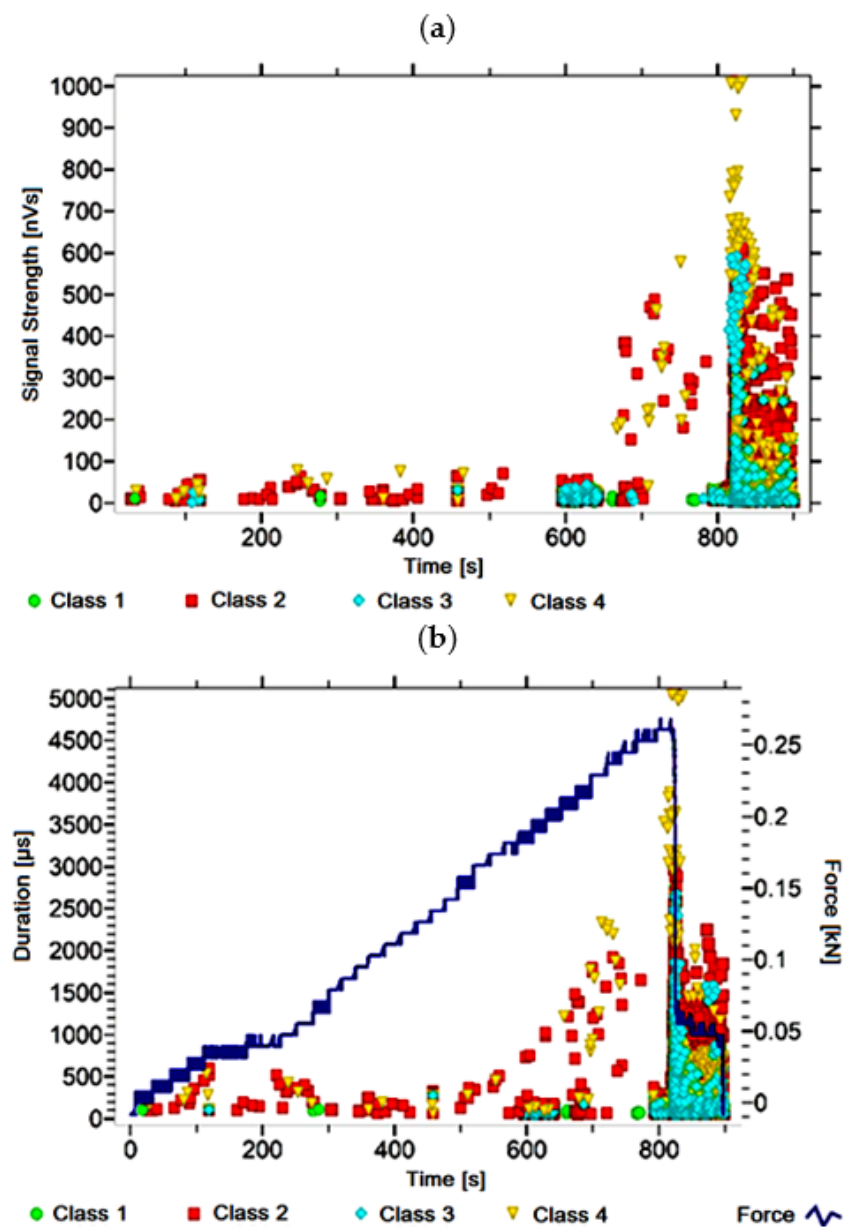
Figure 8. Graphs of acoustic emission signals for an exemplary sample of A 7 series: ( a ) signal strength over time; ( b ) distribution of the duration of the signals over time with the force increment curve.